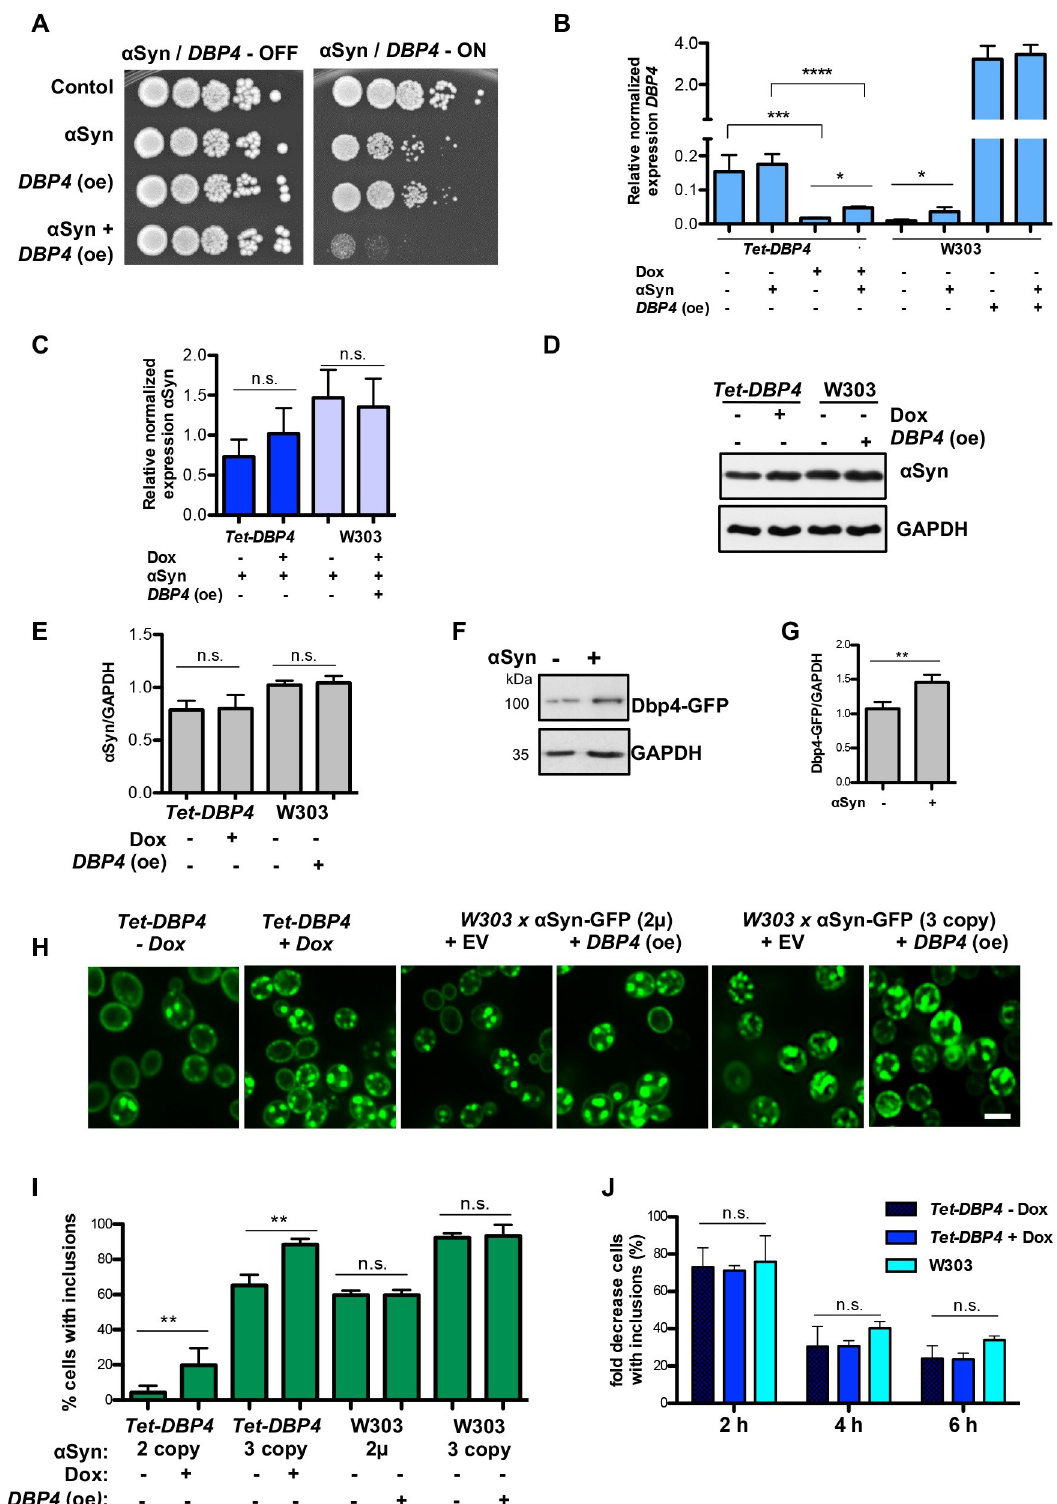
Fig 2. Dbp4 enhances α Syn-mediated growth impairment in yeast. (A) Growth assay of yeast cells expressing GAL1 -driven α Syn- GFP from two genomic copies, either alone ( α Syn) or co-expressed with DBP4 ( α Syn+ DBP4 oe). The isogenic background